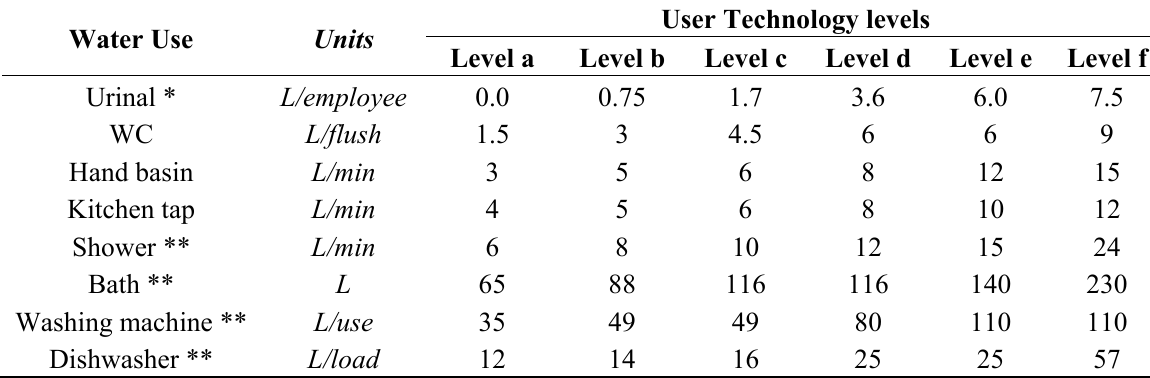
Table 5. Technologies in domestic and office buildings: Level a (best performance) to Level f (worst